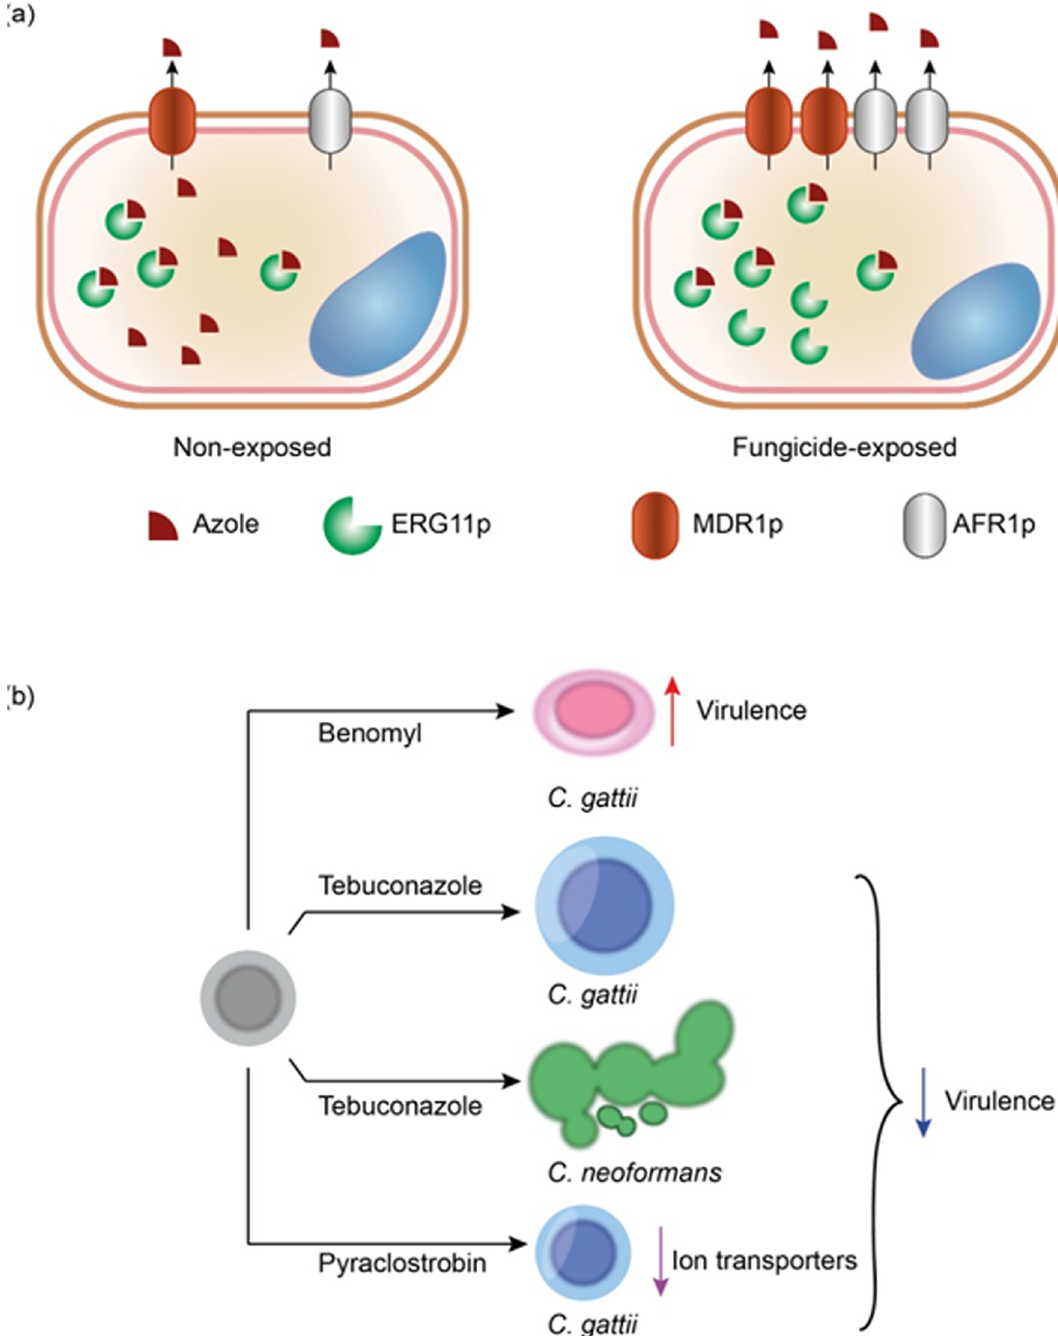
Fig 3. Fungicide exposure effects on Cryptococcus spp. (a) Exposure to fungicides can select cross-resistance to clinical azoles especially through overexpression of efflux pumps ( MDR11 and AFR1 ) and ERG11 genes, the azole target. (b) Different fungicides also can induce important alterations in the cell morphophysiology of Cryptococcus cells that may be related to